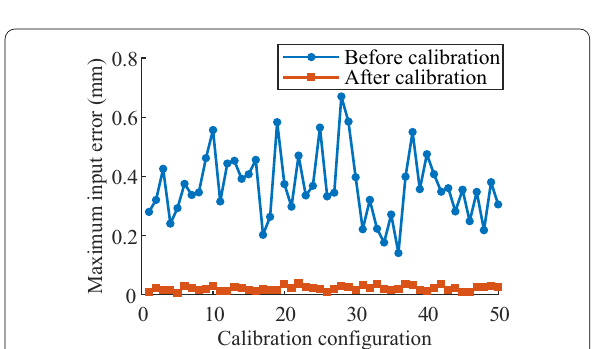
Figure 13 Maximum joint coordinate errors of the parallel manipulator for different calibration